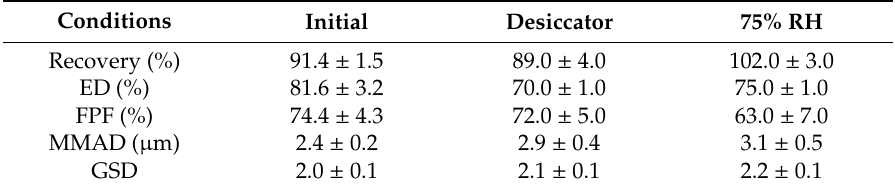
Table 3. Aerosolization performance of the spray-dried bedaquiline (with 20% w / w of l -leucine) powder after one-month storage at 30 ± 2% relative humidity (RH) and ambient room temperature (in desiccator) and at 75 ± 2% RH and 25 ± 2 °C (elevated condition).